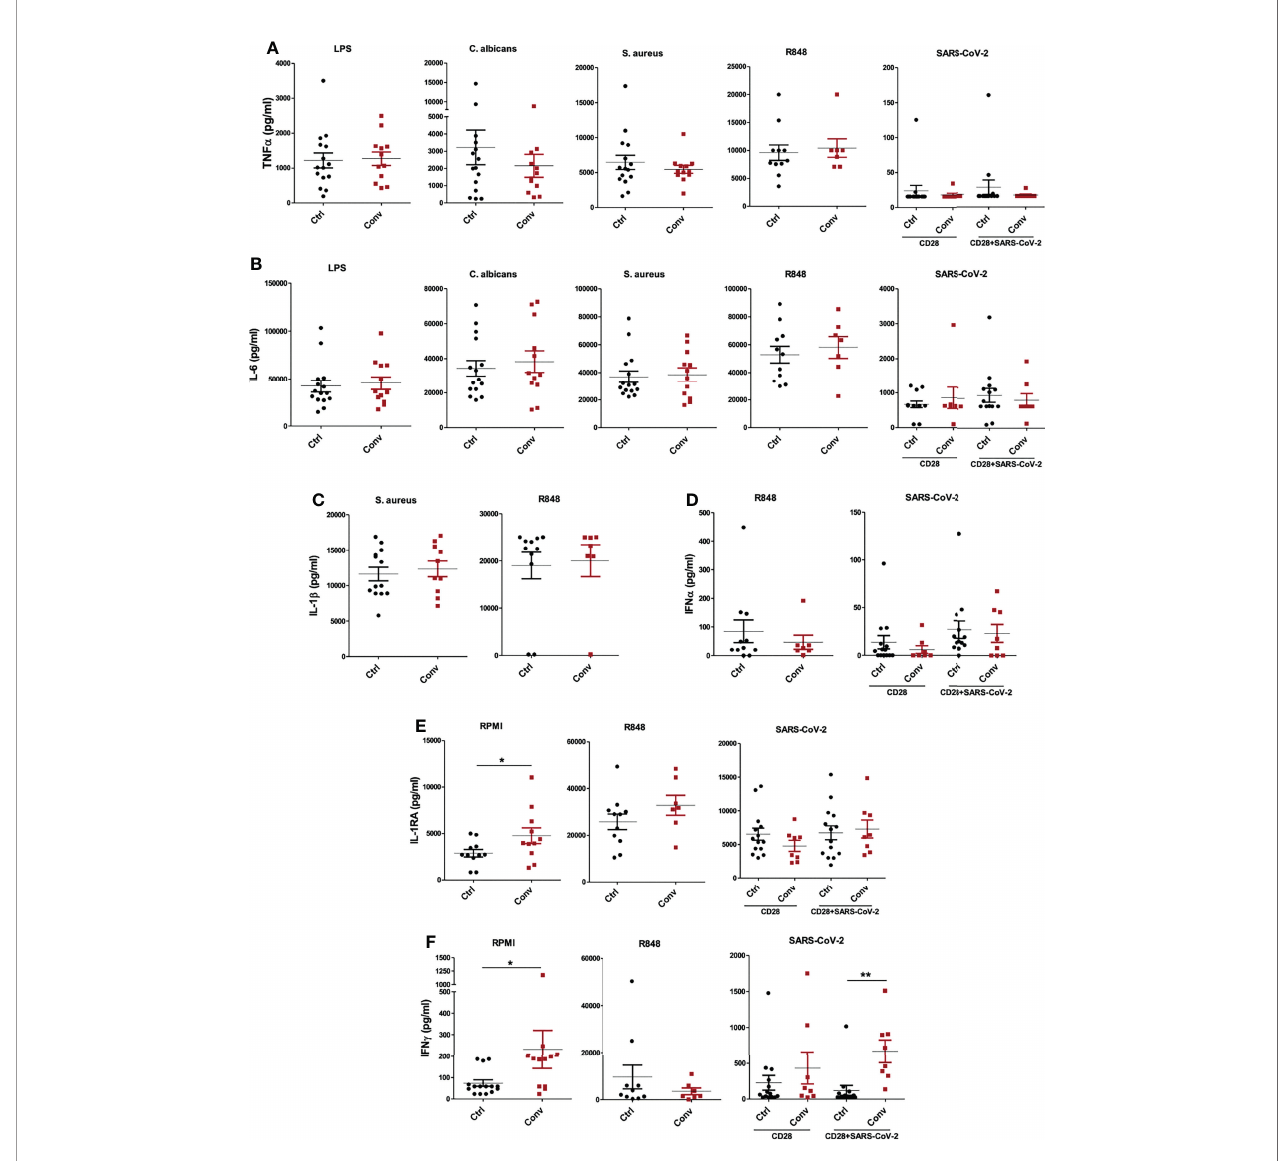
FIGURE 5 | Cytokine production capacity is intact in people recovered from COVID-19. The concentrations of (A) TNF- a and (B) IL-6 after stimulation of PBMCs with LPS, C. albicans , S. aureus, R848, and heat-inactivated SARS-CoV-2. (C) IL-1 b production following S. aureus and R848 stimulation. (D) IFN a levels after incubation with R848 and heat-inactivated SARS-CoV-2. (E) IL-1Ra and (F) IFN- g at the baseline (RPMI condition) and stimulation with R848 and SARS-CoV-2. TNF- a , IL-6, IL-1 b , IFN a and IL-1Ra productions were measured after 24 hours, while IFN- g was measured after 7 days of incubation. Stimulations with R848 and SARS-CoV-2 were performed later with cryopreserved cells, while the rest of the stimulations were done with freshly isolated PBMCs. Mann-Whitney test was used to analyze the differences between controls and convalescent patients (* P value < 0.05, ** P value <